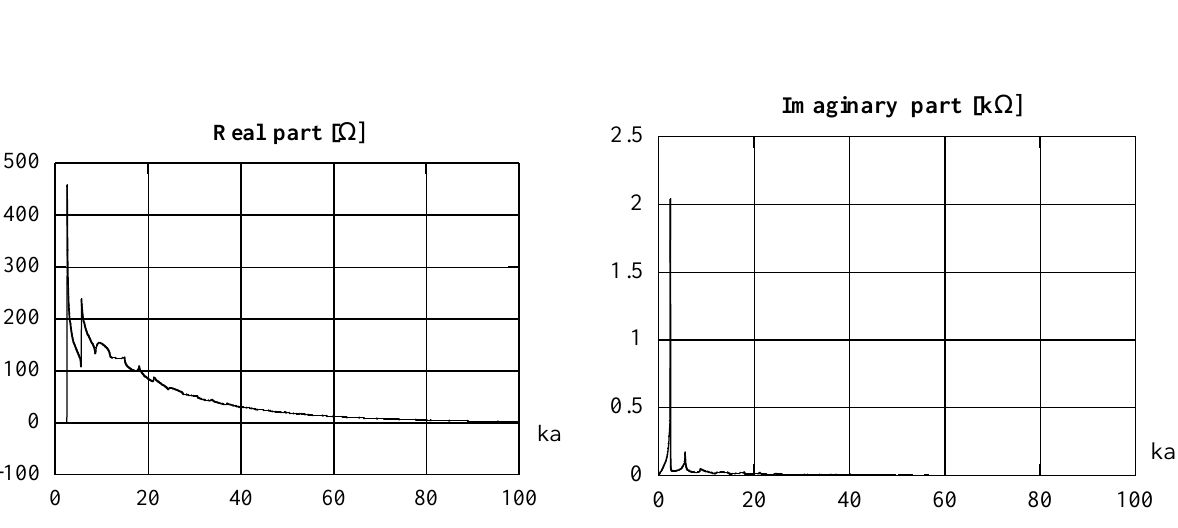
FIG. 13. Real and imaginary parts of the longitudinal coupling impedance in the case (cid:119) (cid:173) (cid:49) (cid:121) (cid:53) and bg (cid:173) (cid:49)(cid:48) .